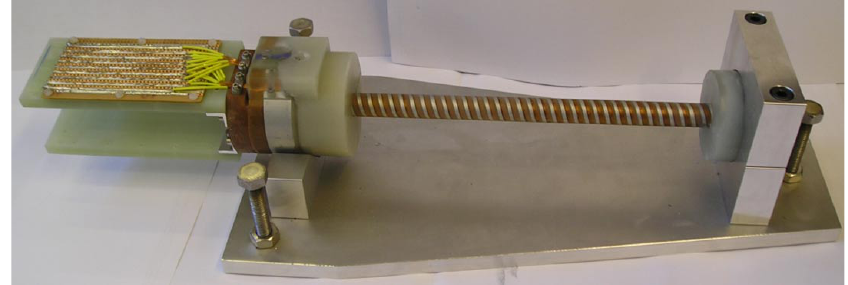
FIG. 10. (Color) Photograph of the completed SC undulator before field measurement, with 20 14 mm